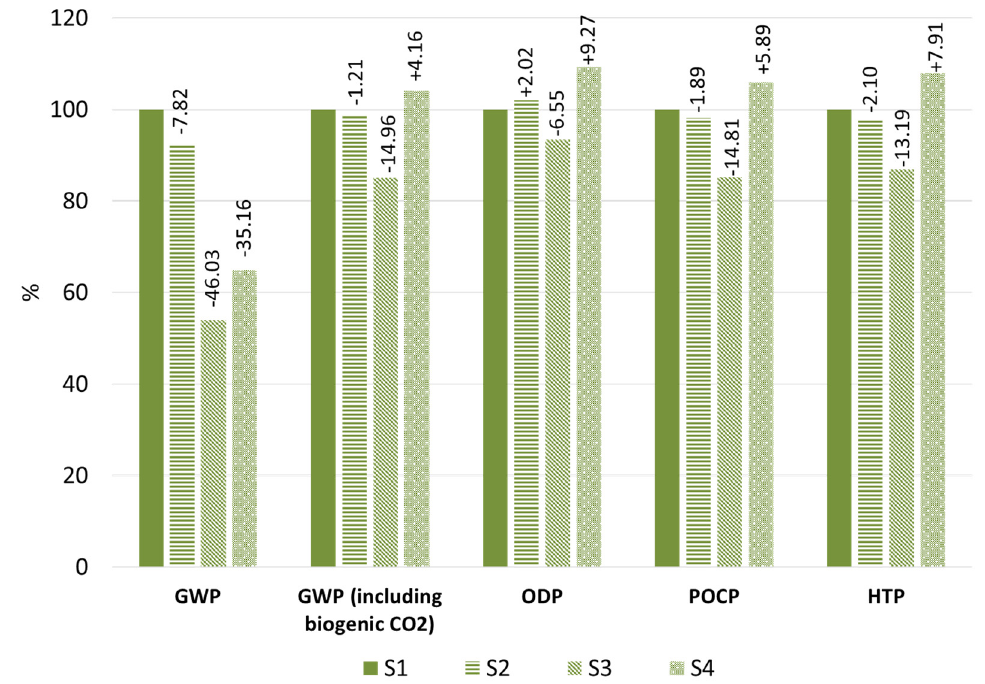
Figure 2. Comparison of the four pellet production systems assessed (S1: pellets produced from sawmill sawdust; S2: pellets produced from roundwood logs; S3: pellets produced from whole trees; S4: pellets produced from logging residues) in terms of Global Warming Potential excluding biogenic CO 2 (GWP), Global Warming Potential including biogenic CO 2 (GWP including biogenic CO 2 ), Ozone Depletion Potential (ODP), Photochemical Ozone Creation Potential (POCP), and Human Toxicity Potential